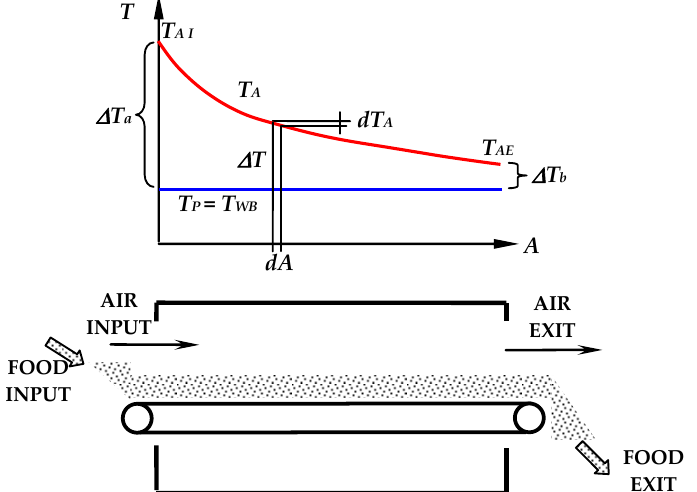
Figure 3. The conveyor-belt dryer with tangential flow and a diagram of the temperatures of the air and the product with a moisture content X F > X C .